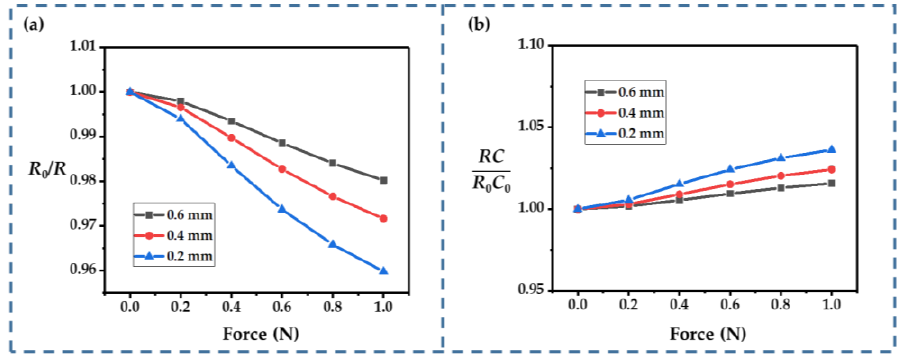
Figure 9. ( a , b ) Influence of the thickness of the electrolyte film on R 0 / R and RC / R 0 C 0 .